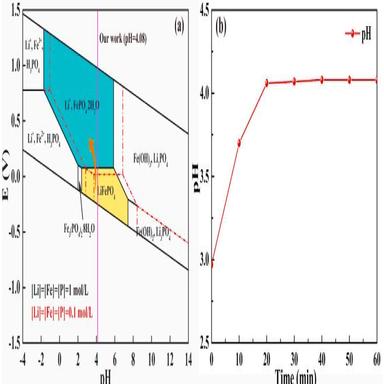
(a) E-pH diagrams for the Li–Fe–P–H2O system at 303.15K for different ionic activity, (b) solution pH changes with time of the leaching reaction (30 min, 30 ◦C, 1.4 times amount of theoretical (NH4)2S2O8), S-L ratio of 50 g L− 1 ).